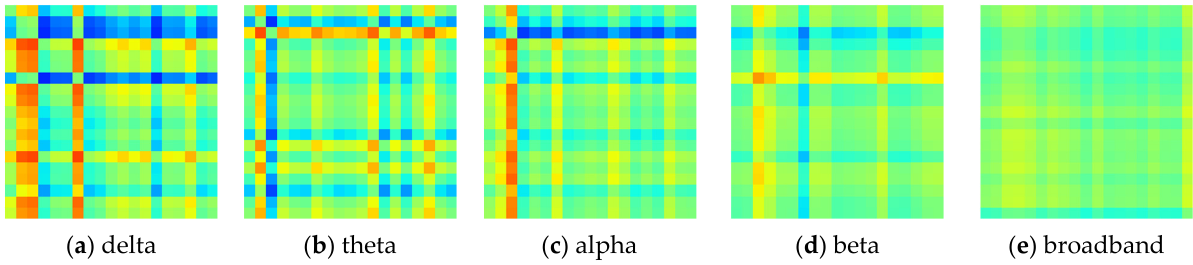
Figure 9. Example of mild sample (BDI score is 14)’s deep-asymmetry image by each band.